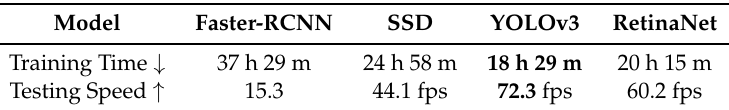
Table 2. Training time and testing speed of vehicle detection methods. The up arrow means that higher is better, while the down arrow means that lower is better. The best values are highlighted using a bold